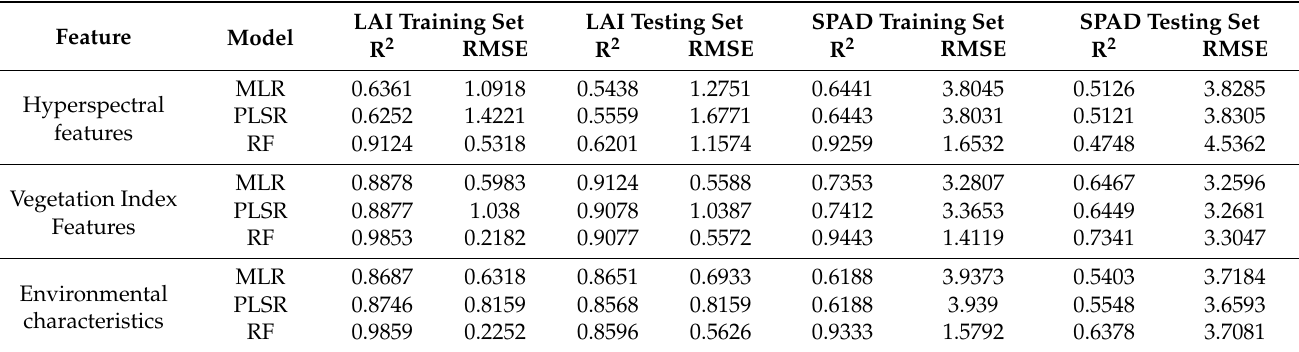
Figure 3. p value for chi − square test for each variable. Table 5. LAI and SPAD inversion models under a single data